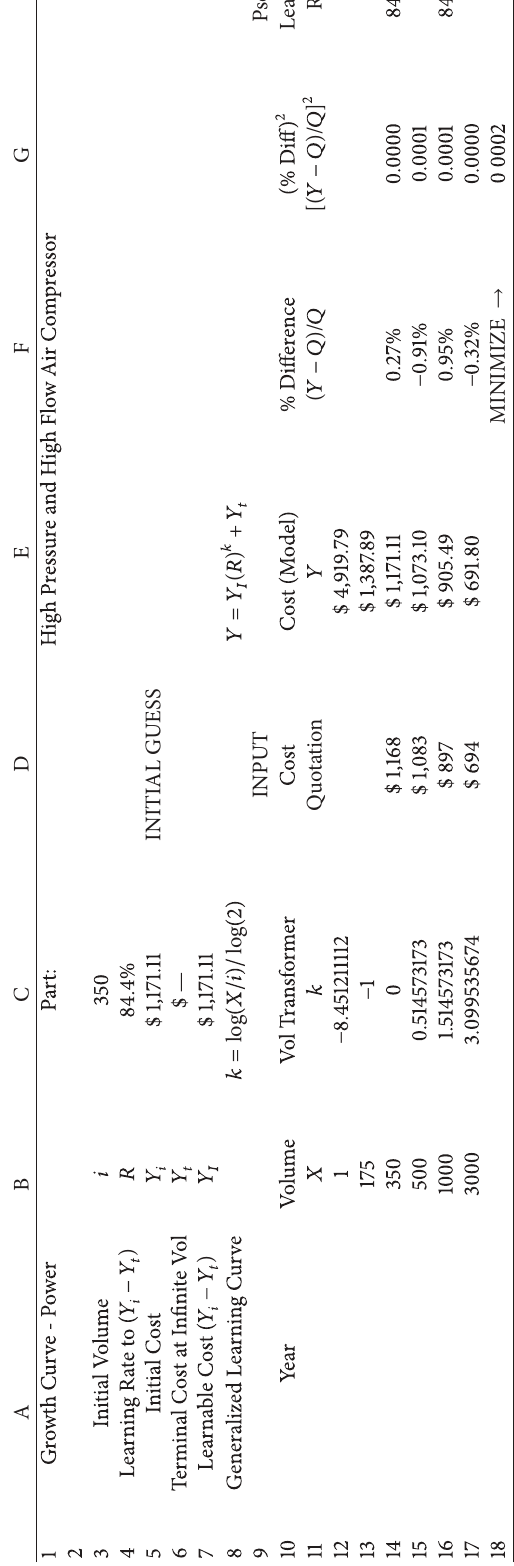
Figure 4: Model summary for air